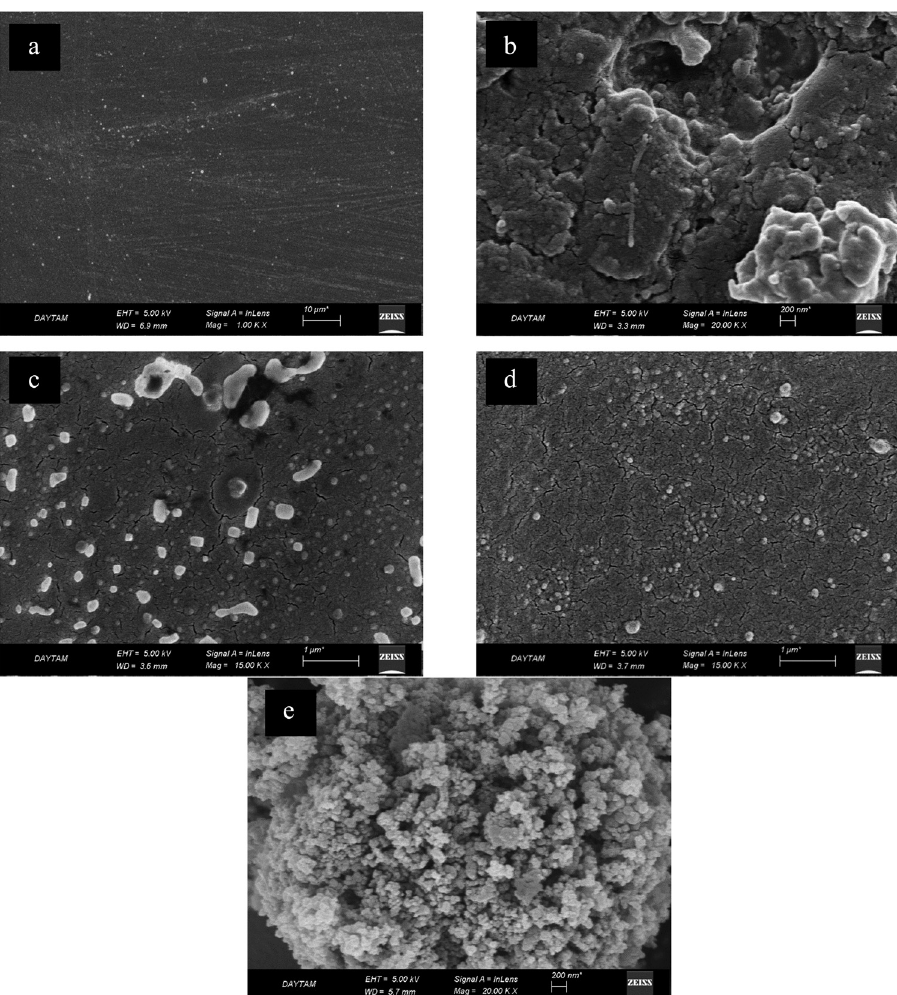
Figure 6: SEM images of carbon black NP doped epoxy composites. ( a ) Neat ( control sample ) , ( b ) epoxy composites with 0.3% carbon black NP, ( c ) epoxy composites with 0.6% carbon black NP, ( d ) epoxy composites with 1% carbon black NP, and ( e ) carbon black